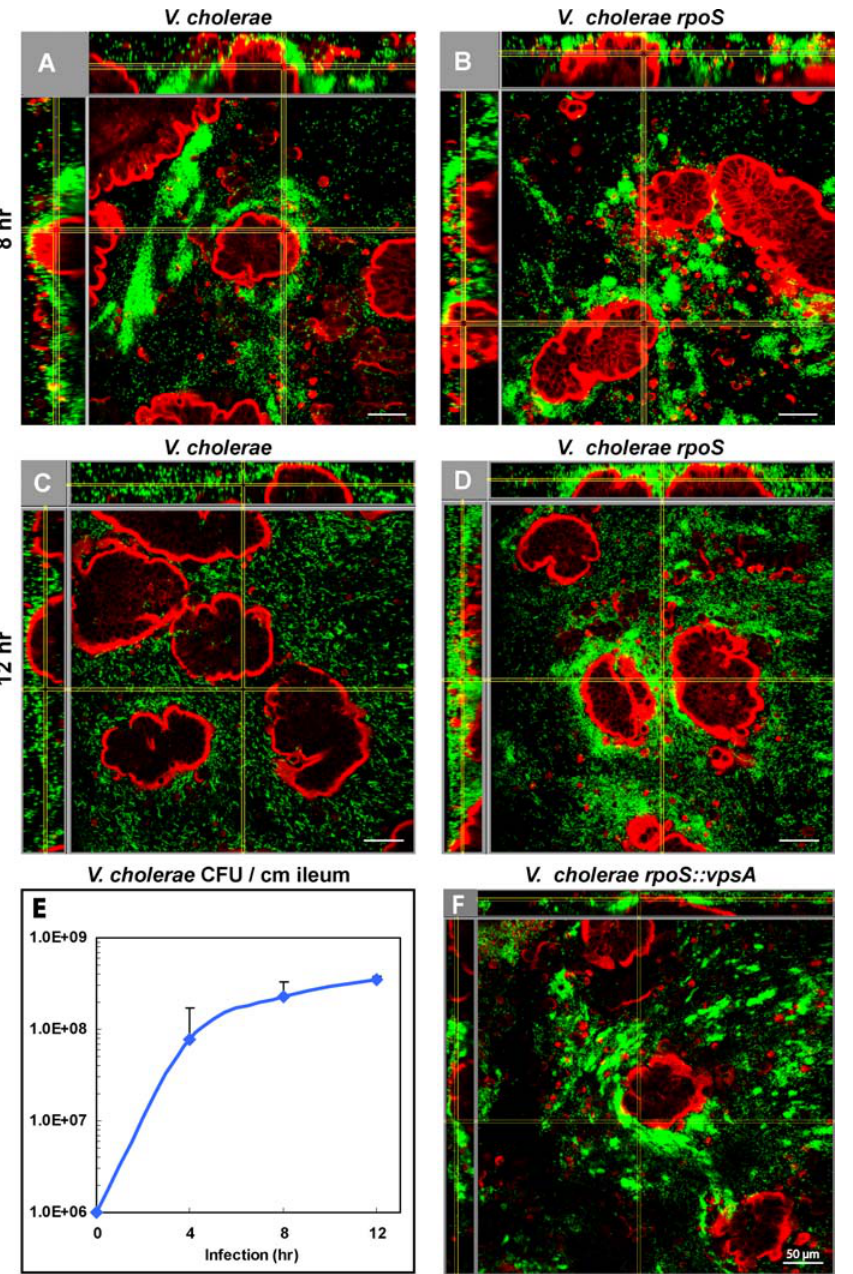
Figure 1. Growth of V. cholerae O1 El Tor, Strain A1552, in Ligated Ileal Loops and the Role of RpoS on Bacterial Localization during Infection Bacteria were visualized using confocal microscopy 8 h (A and B) and 12 h (C, D, and F) post-inoculation of ligated rabbit ileal loops. The actin-rich epithelial surface was stained with phalloidin and is shown with red color, while GFP-tagged V. cholerae are shown with green color. Images are reconstructed Z-projections and show horizontal sections of the villi infected with wild-type V. cholerae (A and C), V. cholerae rpoS (B and D), and V. cholerae rpoS/vpsA (F). Scale bar represents 50 l m. (E) Growth of V. cholerae A1552 in rabbit ligated ileal loops was followed 4, 8, and 12 h post- inoculation based on multiple loops in at least three individual rabbit experiments per time point. Bacterial growth in the luminal fluid was determined by viable plate counts as colony forming units divided by the length of the loop to account for differences in fluid accumulation between loops. DOI: 10.1371/journal.ppat.0020109.g001 PLoS Pathogens |